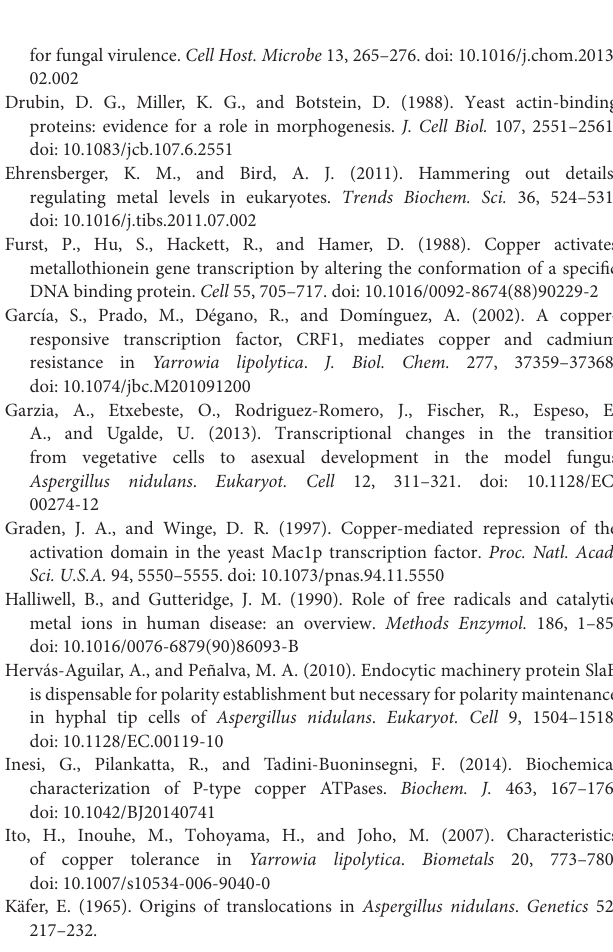
Supplementary Figure 1 | crpA rescue phenotype. WT, ∆ crpA, and crpA + complemented mutant strain characterization in solid medium supplemented with the indicated CuSO 4